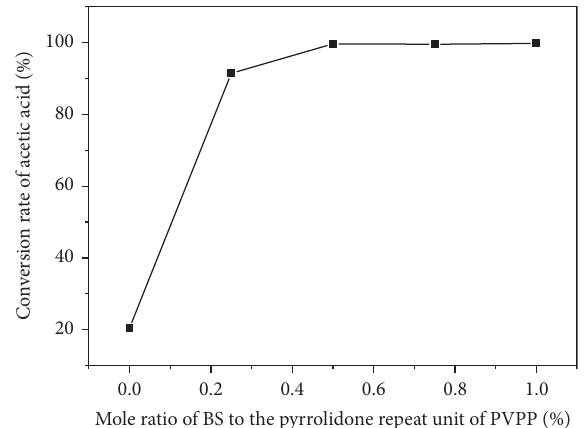
Figure 1: Conversion of acetic acid catalyzed by [ PVPP-BS ] HSO 4 catalysts synthesized with different mole ratios of BS to the pyrroli- donerepeatunitofPVPP.(Reactionconditions:n-butanol96 mmol, acetic acid 80mmol, [ PVPP-BS ] HSO 4 catalyst 8wt%, and 90 ∘ C for 3 h.)